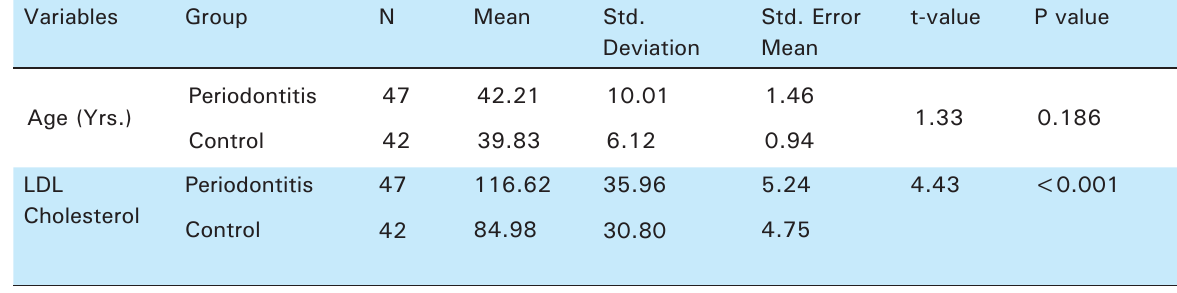
Table 1. Mean Age and LDL-Cholesterol Distribution among the Groups. Variables Group N Mean